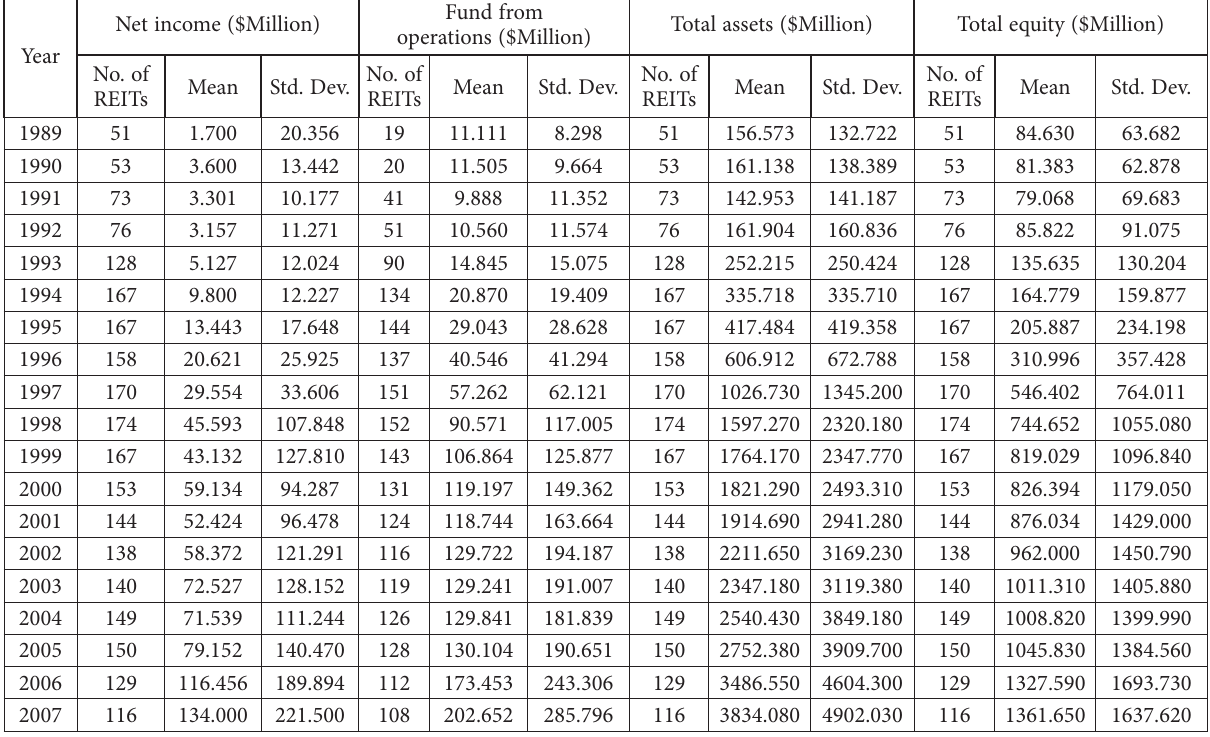
Table 1. Annual means and standard deviations of sample REITs’ net income, funds from operations, total assets, total equity, and ROE, during the sample period of 1989–2015 Panel A: Net income, funds from operations, total assets and total